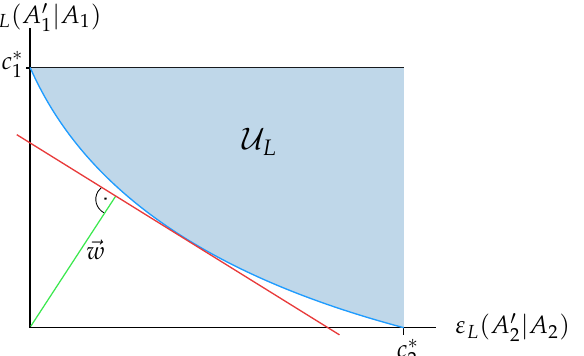
Figure 8. The lower bound of the uncertainty region U L can be described by its supporting hyperplanes (red line) with a normal vector (cid:126) w ∈ R n +